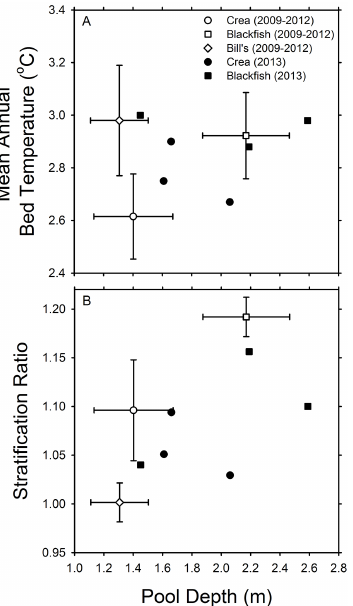
Figure 12. Thermal regime characteristics of single pools at three beaded streams averaged over 4a (error bars are standard devia- tions). In 2013, three additional pools within two of these beaded streams were monitored to assess within-stream variability of ther- mal characteristics. Thermal regimes were characterized by mean annual temperatures at pool beds (a) and stratification ratios as the average ratio between the pool surface and bed during the period from July to mid-August in each year (b) . Pool depths are averaged during the same period that temperature was summarized in each plot.